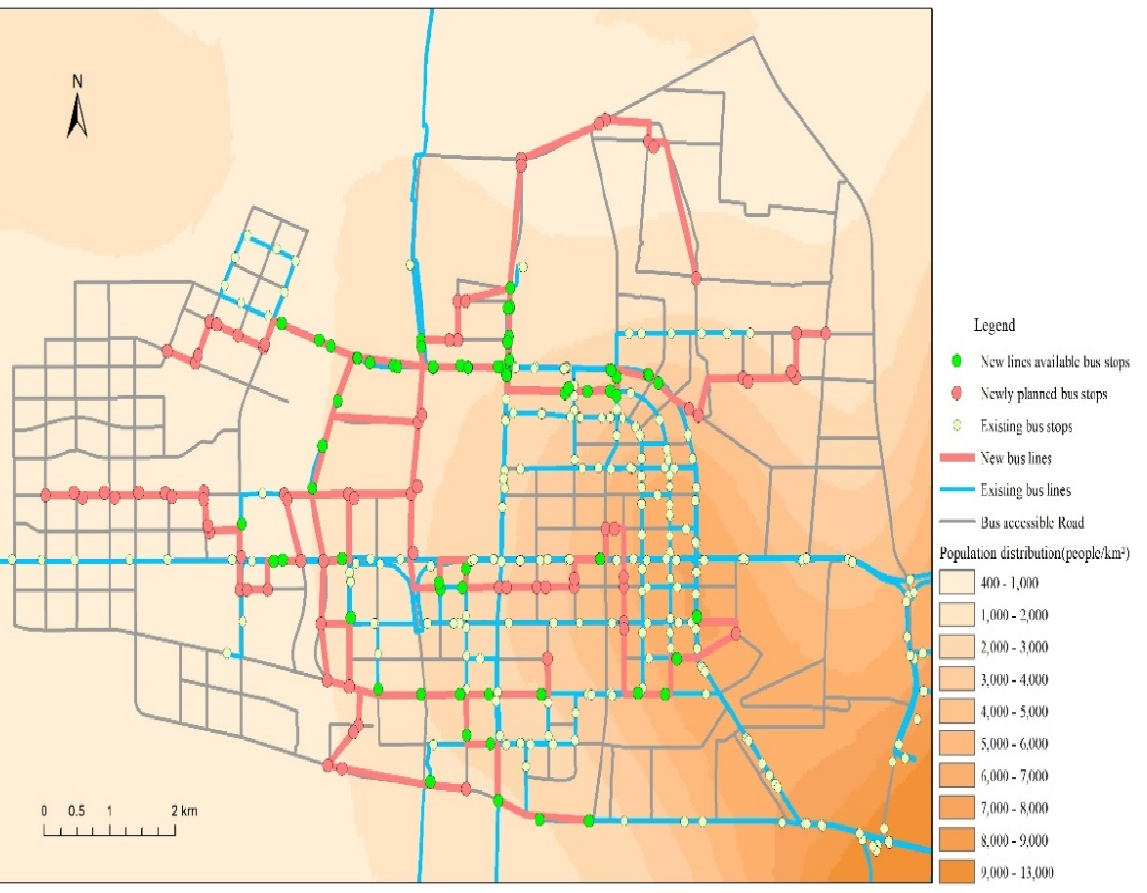
Figure 9. Distribution of bus-line network, stations, and population density.